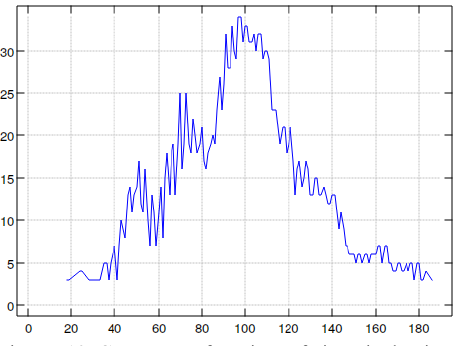
Figure 13 Current as function of time in busiest voxel in the building, according to shortest path evacuation model It should be noted that all quantities shown are dimensionless numbers. They are expected to have (linear) relationships to relevant variables, such as crowd densities, speeds and durations, but the conversion factors have not been established